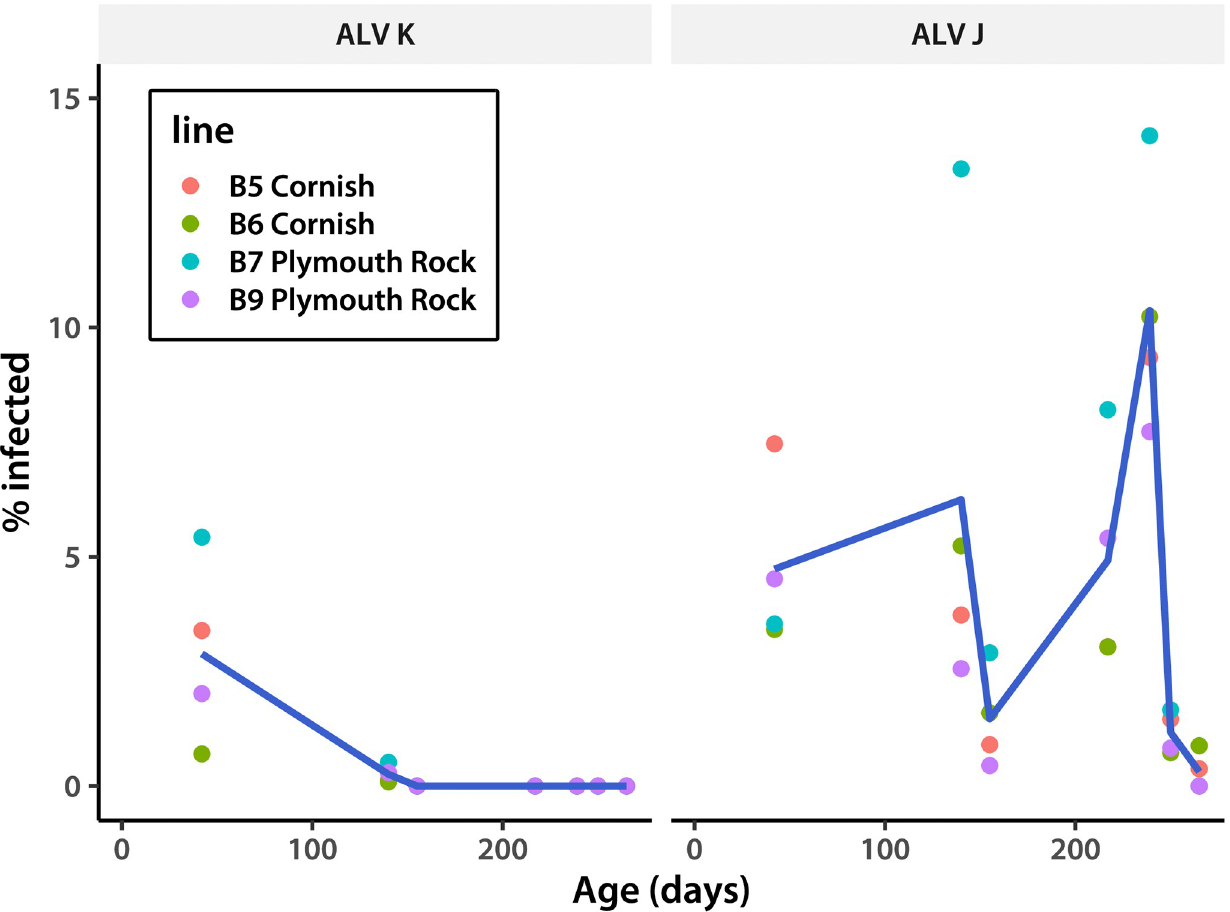
Fig 2. Prevalence of infected individuals over time. Data for ALV K and J infections are shown on separate panels. Lines trace among-line means, calculated for each day separately. The data for this plot are in Table 2.